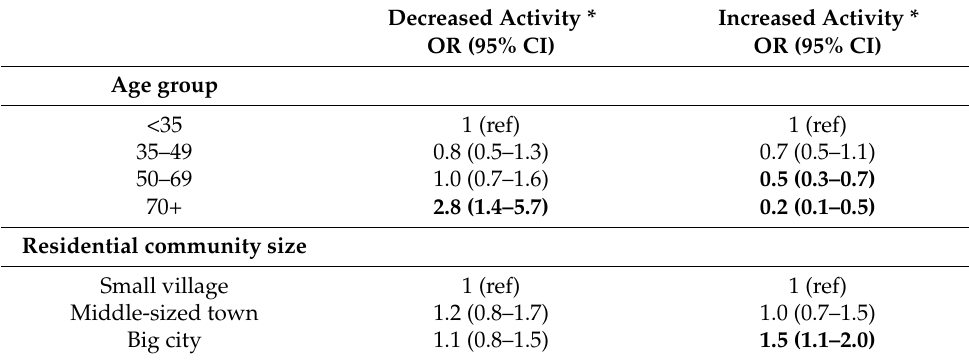
Table 4. Odds ratios (OR) for increased and decreased activity in different age groups and place of residence.